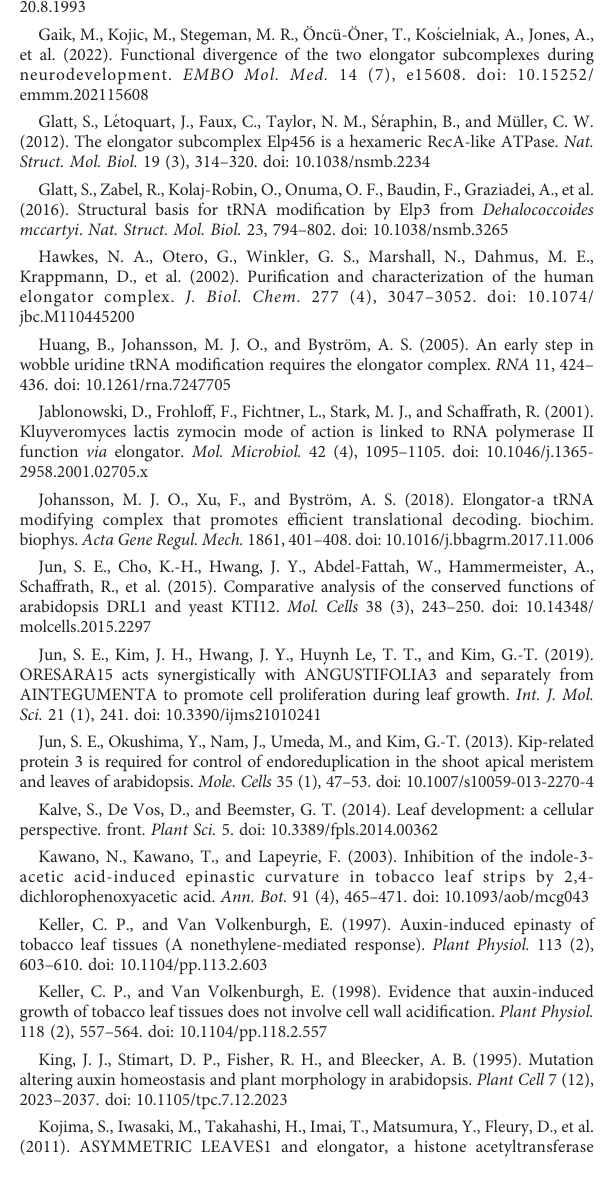
SUPPLEMENTARY FIGURE 3 Distribution of DNA ploidy on the mature 3 rd rosette leaves of plants on 21